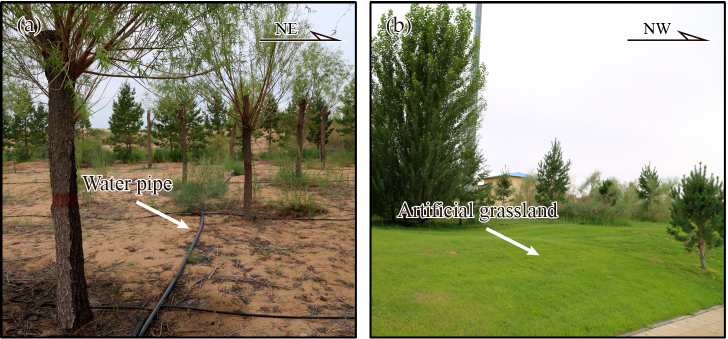
Figure 12. Photos showing the desertification reversion induced by afforestation ( a ) and grass planting ( b ). Their locations are shown in Figure 11.